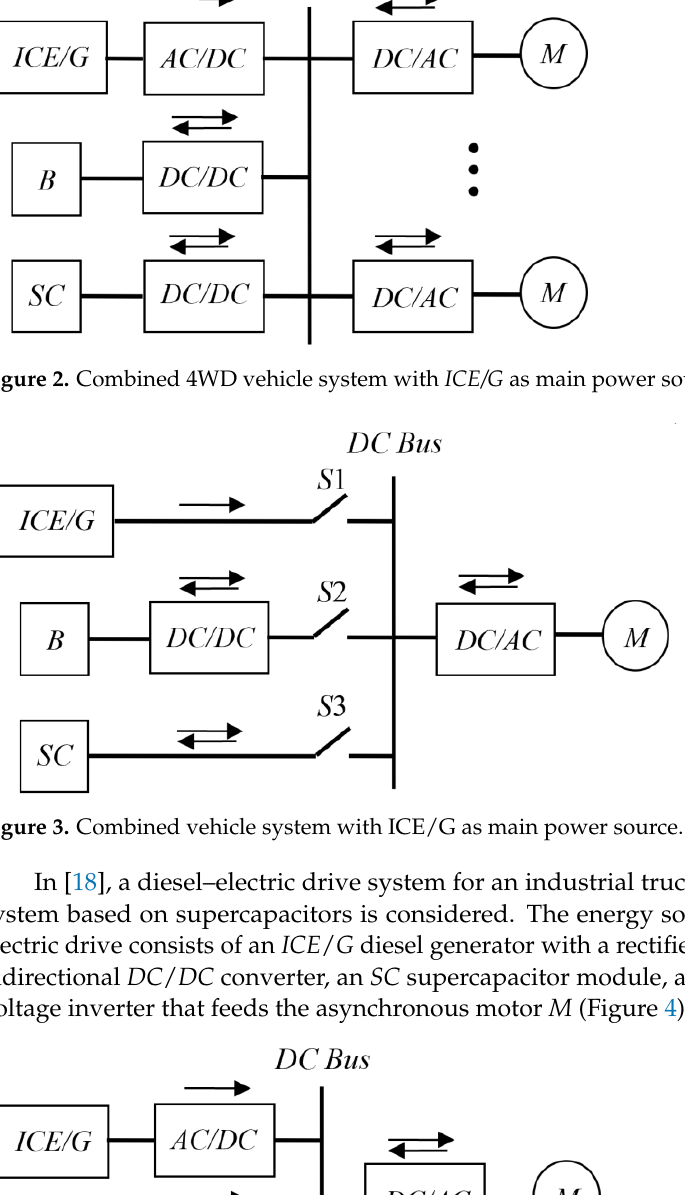
Figure 3. Combined vehicle system with ICE/G as main power source.